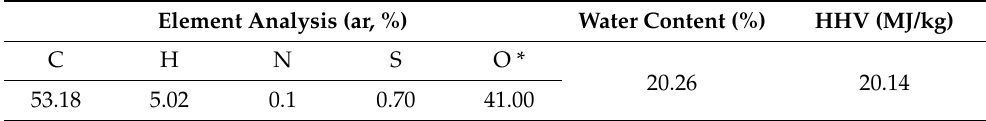
Table 2. Element analysis and calorific value of bio-oil (wt.%).